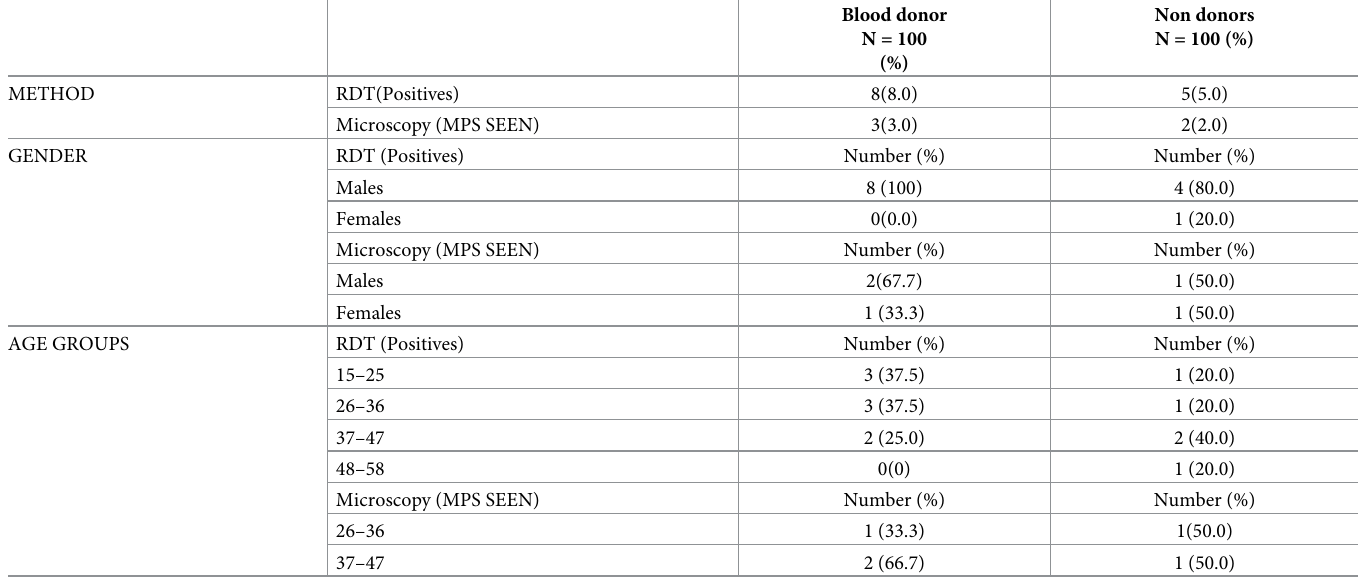
Table 2. Comparison of the prevalence rate of malaria using microscopy and